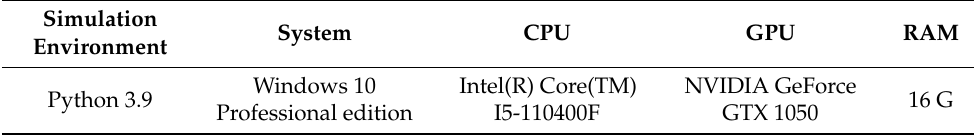
Figure 8. Environments for the simulations. ( a ) Regular environment; ( b ) Cluttered environment; ( c ) Maze. (Red dot: start state, green circle: goal region.) ( c ) Maze. (Red dot: start state, green circle: goal region.). Table 1. System and resource characteristics. Table 1. System and resource